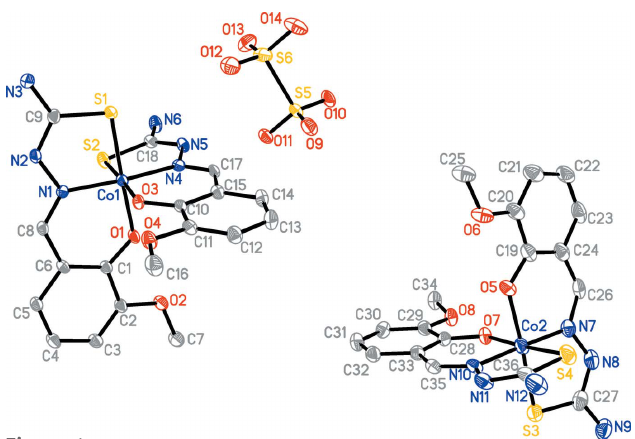
Figure 2 The crystal packing of the title compound viewed along the a axis. N— H (cid:2)(cid:2)(cid:2) O and O—H (cid:2)(cid:2)(cid:2) O hydrogen bonds, which link the components in the crystal, are shown as dashed lines. C-bound hydrogen atoms are omitted for